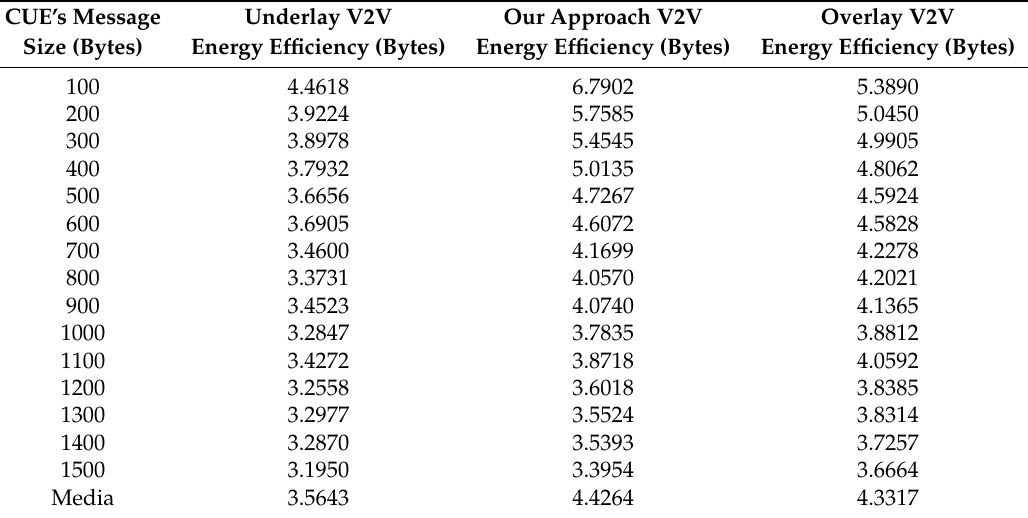
Table 8. Average Total Energy Efficiency achieved based on C-UEs’ traffic pattern.